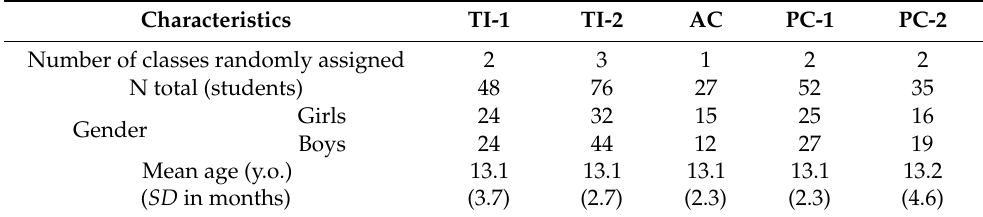
Table 1. Sample characteristics as a function of the intervention